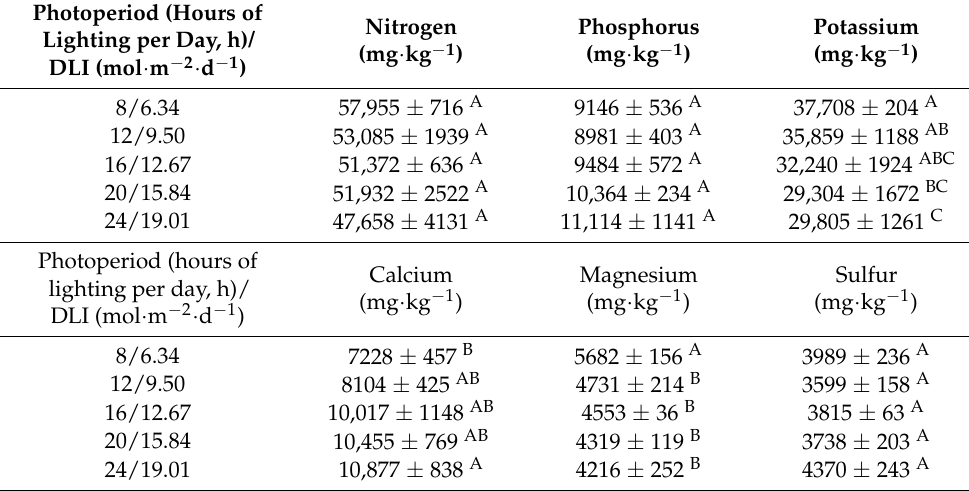
Letters represent mean separation comparison across light treatments within the same harvest day using Tukey’s HSD (alpha =